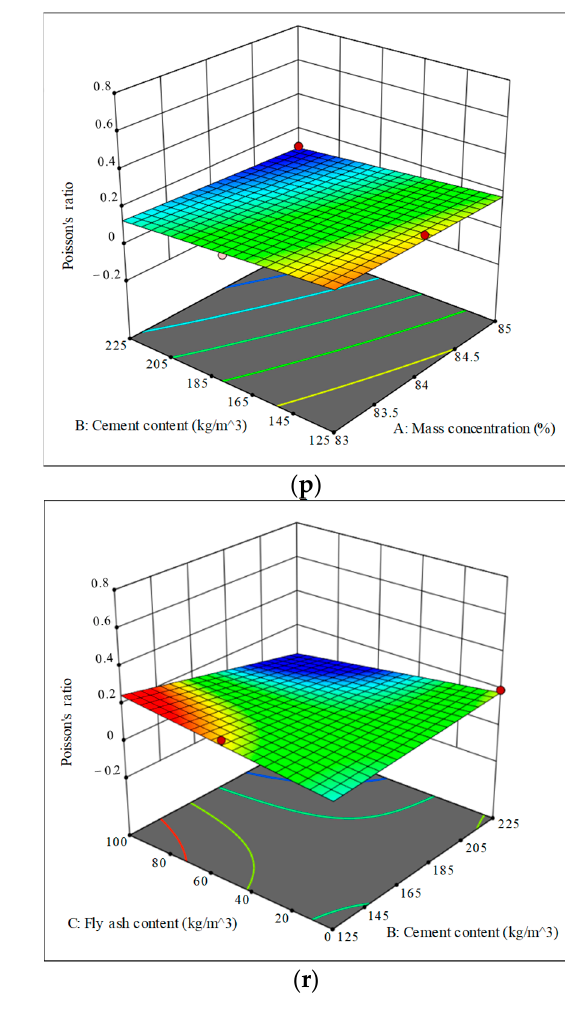
Figure 8. Response surface of different factors to each index.